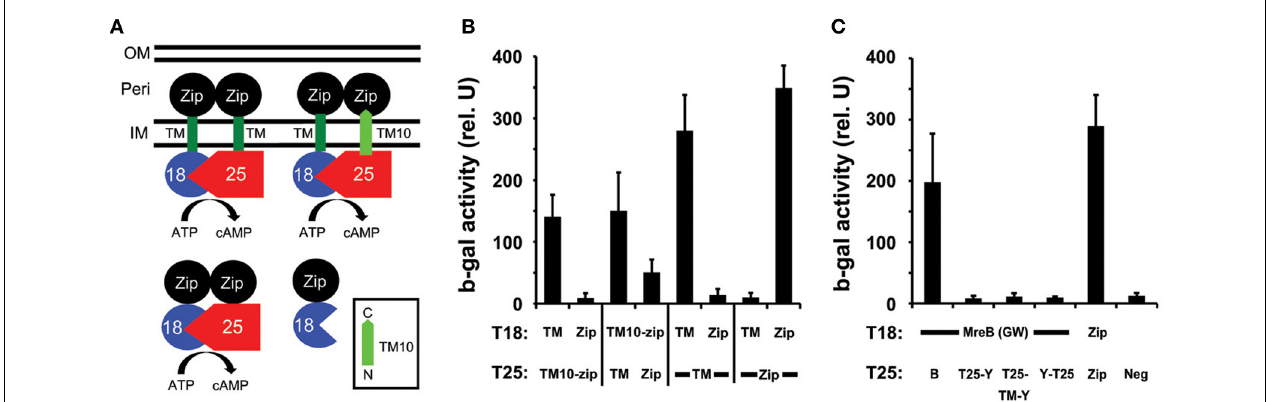
FIGURE 2 | Determination of the orientation of MraY and its interaction with MreB using the BACTH system. (A) The 26 amino acids encoding TM10 of MraY (residues 311–336; light green with predicted orientation boxed in bottom right of A ) were cloned between the leucine zipper domain, Zip (black circle), and the T18 (blue pie shape) or T25 (red pentagon) fragment of adenylate cyclase to create the product T25-TM10-zip or T18-TM10-zip. These were tested against the positive control vectors encoding T25-Zip or T18-Zip and T25-TM-zip or T18-TM-zip (indicated as TM in (B,C) with the transmembrane domain of OppB from E. coli ; dark green). The diagram illustrates the expected interactions with T18-TM-zip if T25-TM10-zip has its C-terminus in the periplasm as